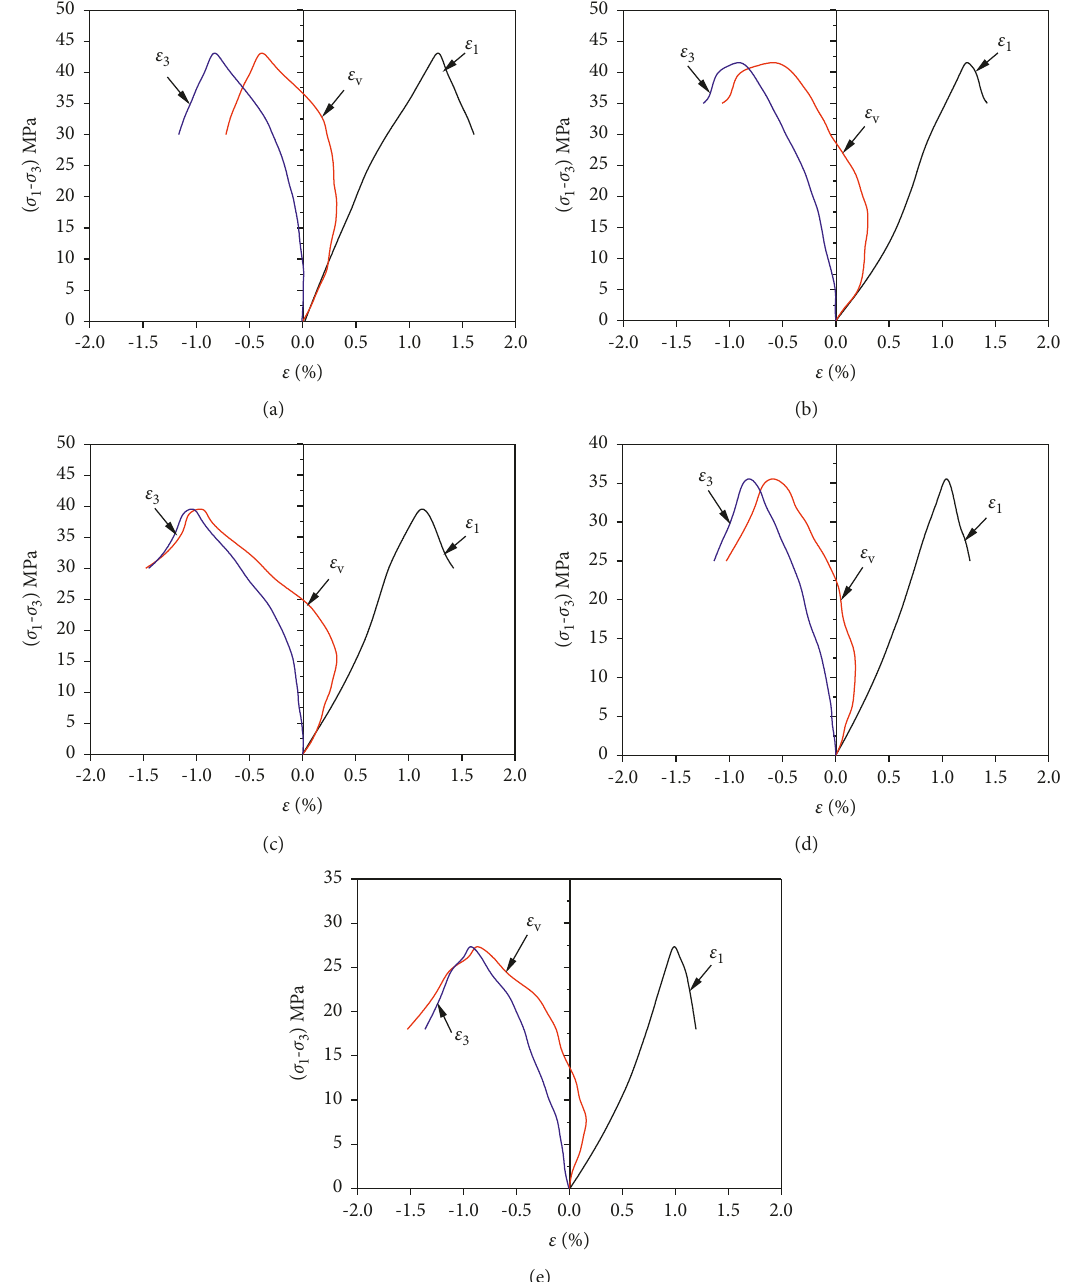
Figure 6: Stress-strain curve of the PD rock. (a) S-0 rock sample. (b) S-1 rock sample. (c) S-2 rock sample. (d) S-3 rock sample. (e) S-4 rock